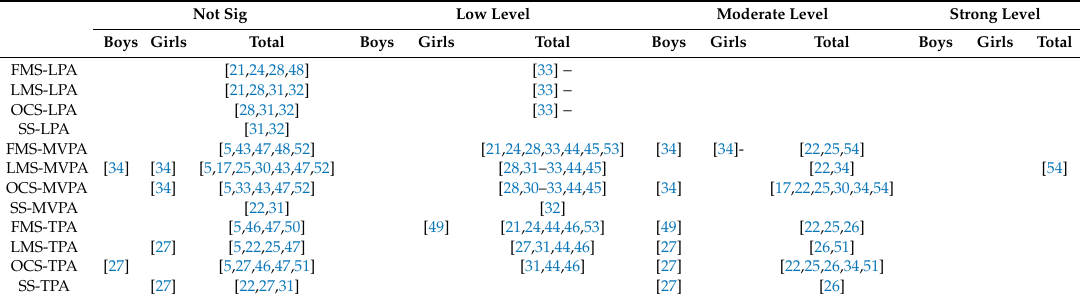
Table 4. The strength of associations between fundamental movement skills (FMS) types and specific-intensity physical activity (PA) by gender. Not